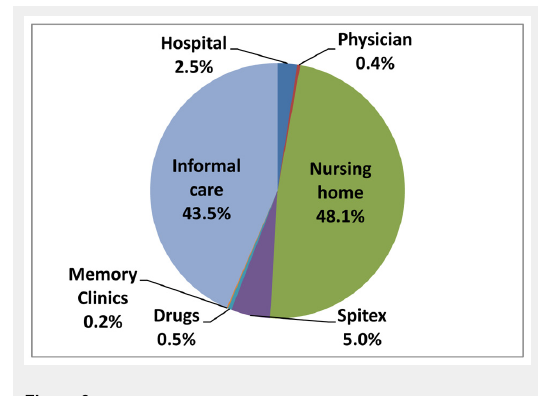
Estimated cost distribution in the year